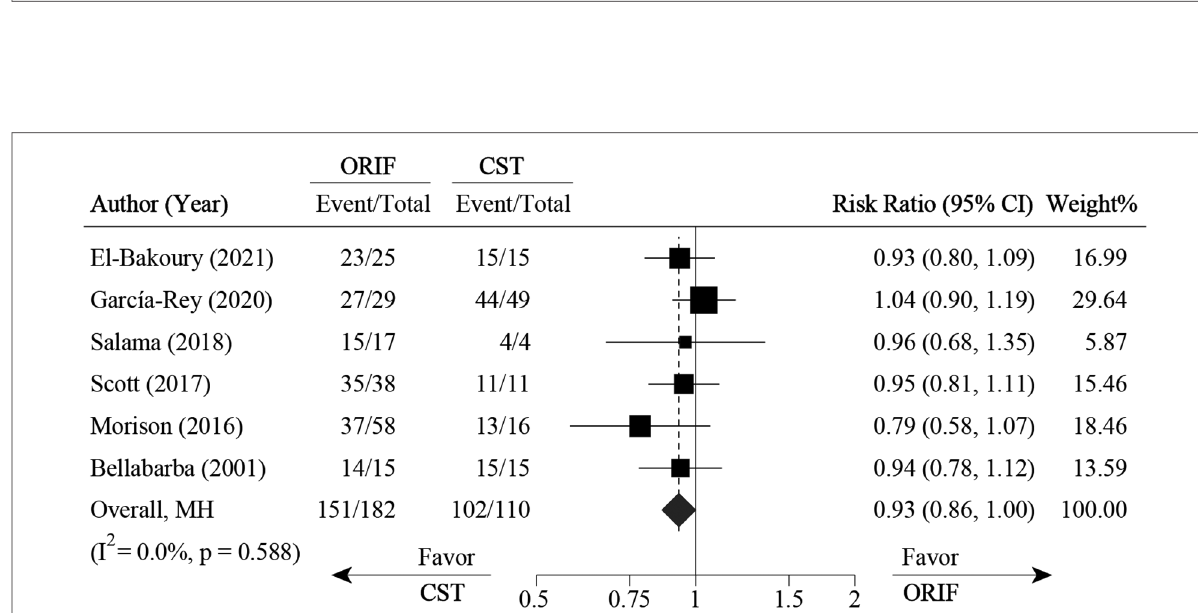
FIGURE 6 Trim and fi ll analysis for HHS comparison between posttreatment and pretreatment. HHS, harris hip